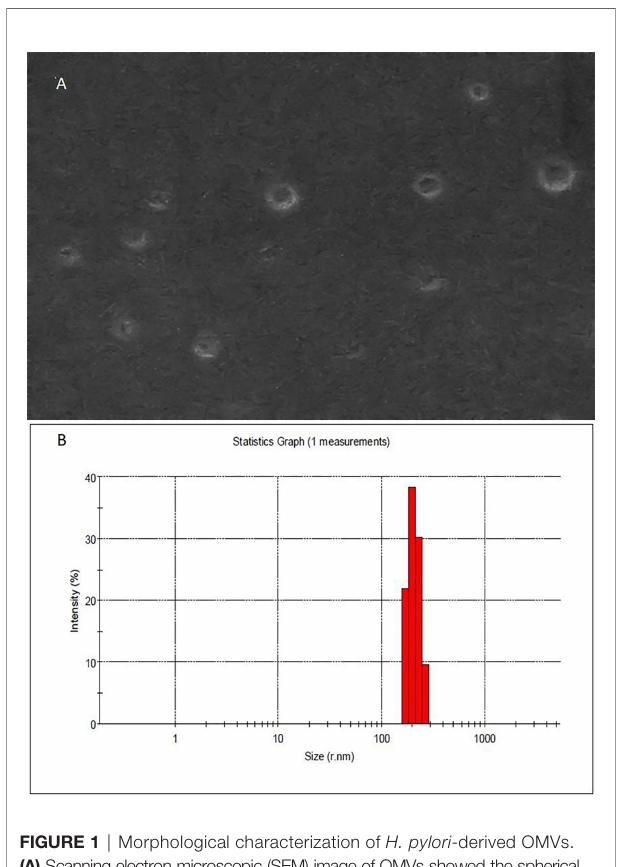
FIGURE 1 | Morphological characterization of H. pylori -derived OMVs. (A) Scanning electron microscopic (SEM) image of OMVs showed the spherical and double-layered vesicles in different sizes. (B) Physicochemical characteristics of H. pylori -derived OMVs based on DLS. Size distribution is determined based on the intensity of OMVs in the ultracentrifugation technique. DLS con fi rmed nano- sized OMVs in a range of about 130 – 300 nm, peaked at 200 nm.